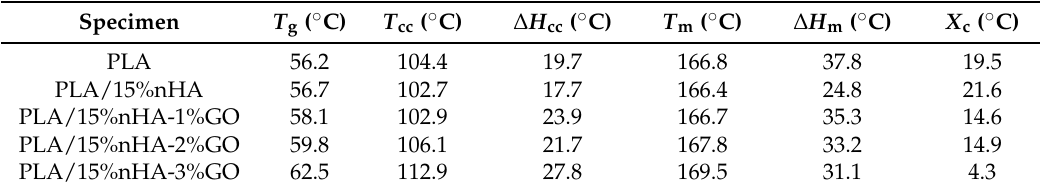
Figure 8. Second heating curves of electrospun ( a ) PLA, ( b ) PLA/15%nHA, ( c ) PLA/15%nHA-1%GO, ( d ) PLA/15%nHA-2%GO and ( e ) PLA/15%nHA-3%GO fibrous mats. Table 2. Thermal parameters of the samples investigated.